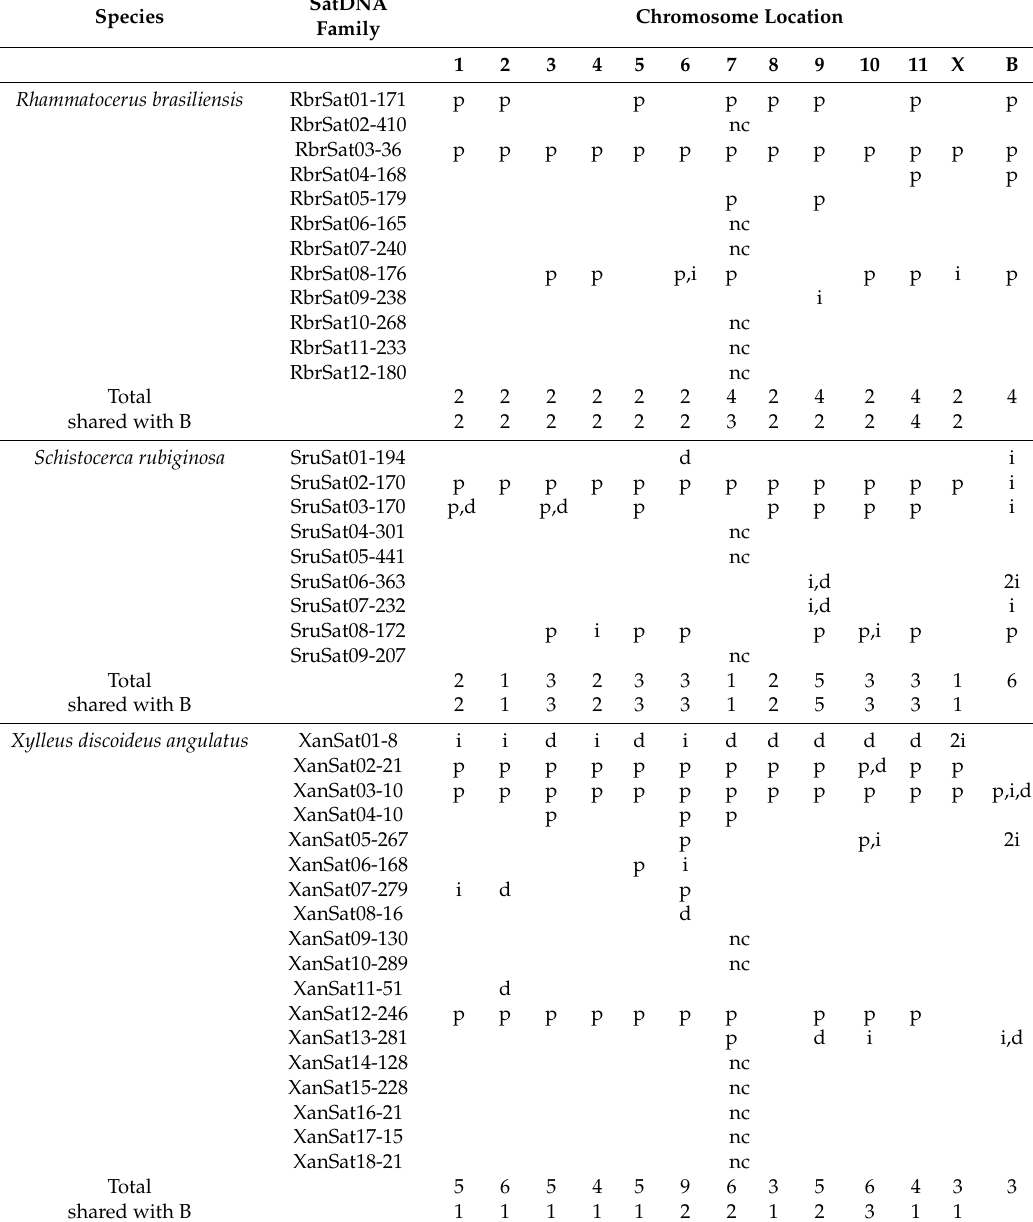
Table 2. Chromosome location of satDNAs in three grasshopper species. For each species at the bottom is indicated the number of satDNA families per chromosome and the amount of satDNAs shared with the B chromosome. p: pericentromeric, i: interstitial, d: distal, nc: nonclustered.